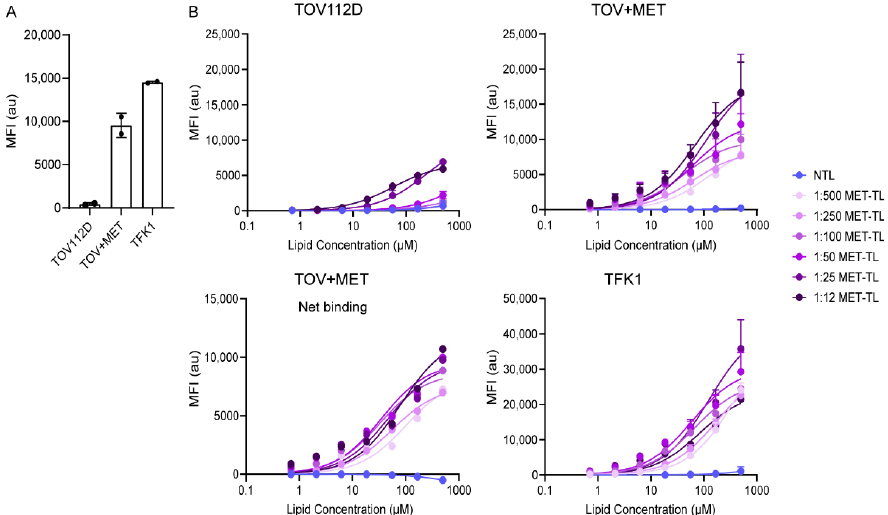
Figure 3. MET-targeted liposomes (MET-TLs) bind specifically to MET-expressing cells. ( A ) MET receptor expression on TFK1, TOV112D, and TOV+MET cells measured by flow cytometry. The mean fluorescence intensity (MFI) of the fluorescently labeled anti-MET antibodies is plotted as a function of cell line. ( B ) A binding experiment was performed by incubating TOV112D (-MET) and TOV+MET as well as TFK1 (+MET) cells with dispersions of non-targeted liposomes (NTLs) and MET-TLs with different MET-Nb densities for 1 h at 4 °C. The lipid concentration varied from 0.7 to 500 µM. Specific binding (net binding) to TOV+MET cells was inferred by subtracting the TOV112D binding traces, i.e., the negative control for MET, from the traces of MET-expressing cells. Data were normalized to the mean of the control group (non-treated cells) and expressed as mean ± SD of two independent experiments (performed in duplicate). The binding curves were fitted using GraphPad Prism.